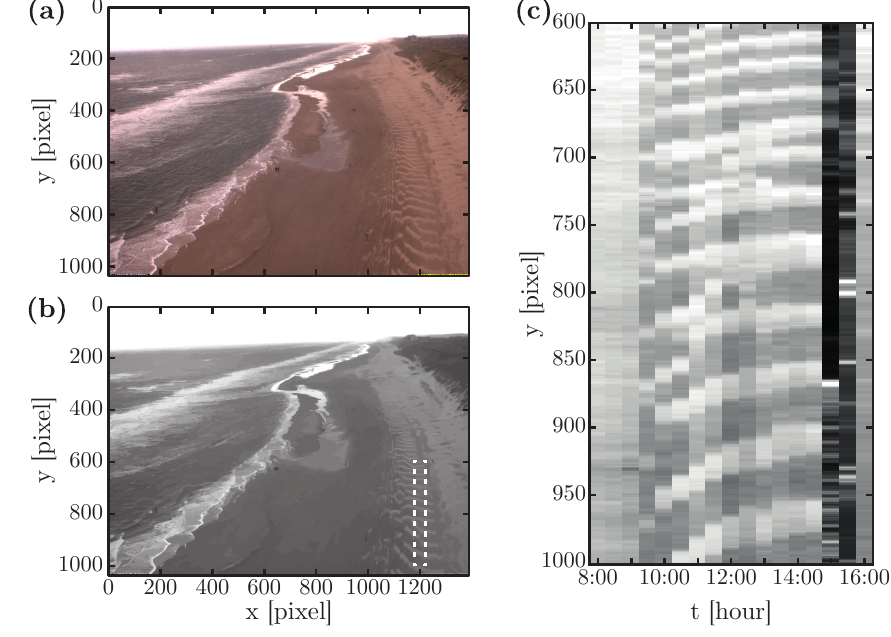
Figure 8. ( a ) Color and ( b ) grayscale Argus image of 19 October 2009 at 10:00 a.m. ( c ) Pixel Intensity plot of grayscale images of a whole day (8:00 to 16:00 h) to detect aeolian sand transport. The pixel area shown in the intensity plot corresponds to the line at pixel 1200 in the horizontal axis, and between pixels 600 to 1000 in the vertical axis, which is located inside of the white rectangular area, in the grayscale image ( b